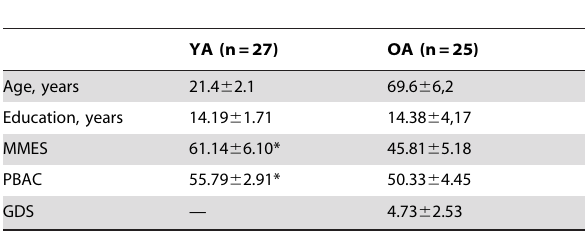
Table 1. Demographic and clinical